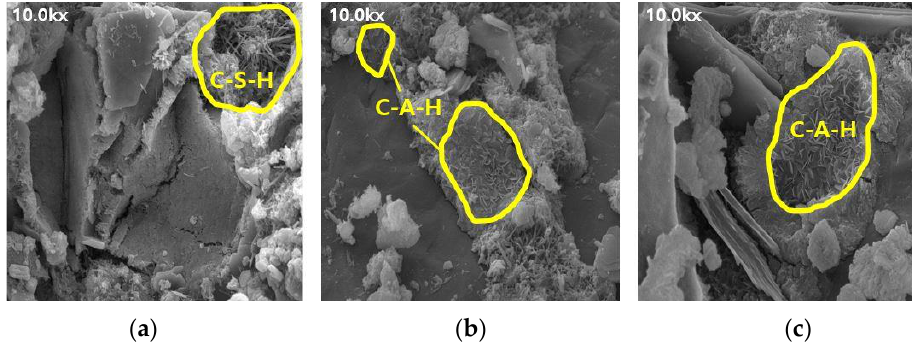
Figure 5. SEM results of BFS25: ( a ) 3, ( b ) 7, and ( c ) 28 d.